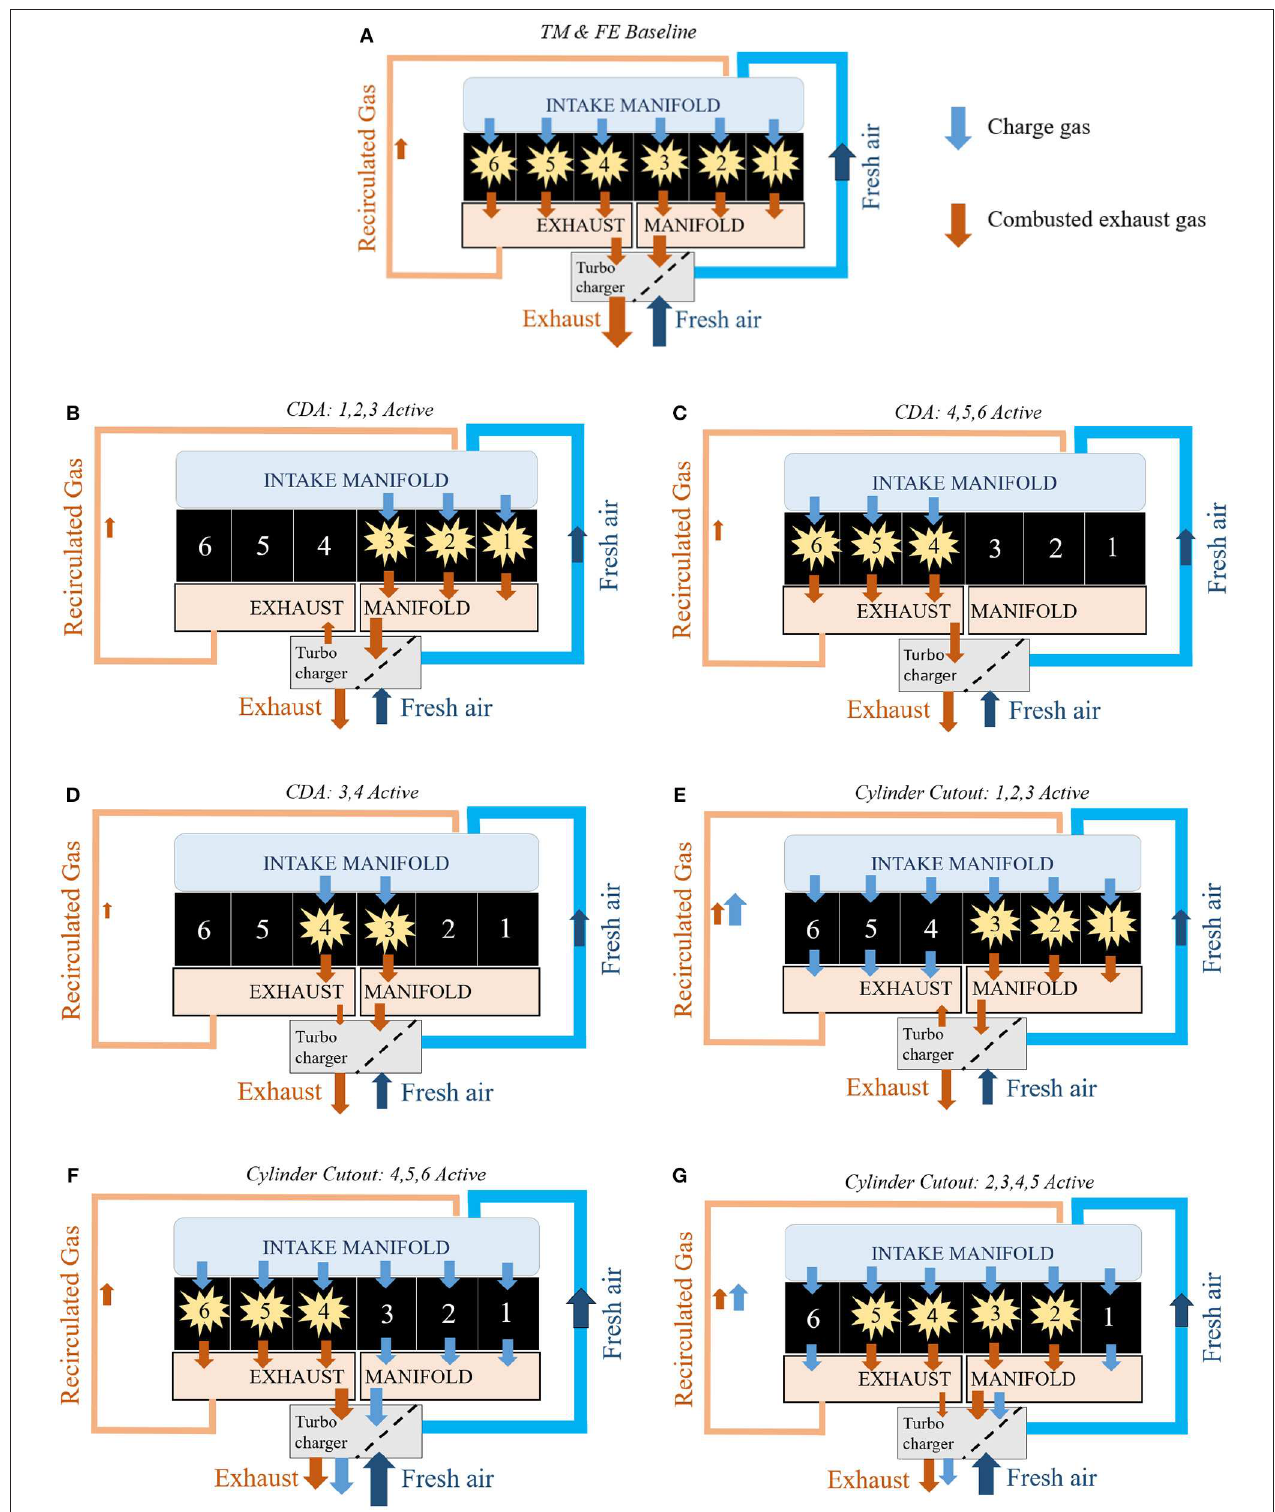
FIGURE 3 | (A) Normal operation with the engine firing in all six cylinders. (B) Three cylinder CDA operation with the engine firing in the first three cylinders. (C) Three cylinder CDA operation with the engine firing in the last three cylinders. (D) Four cylinder CDA operation with the engine firing in the middle two cylinders. (E) Three Cylinder Cutout operation with the engine firing in the first three cylinders. (F) Three Cylinder Cutout operation with the engine firing in the last three cylinders. (G) Two Cylinder Cutout operation with the engine firing in the middle four cylinders.